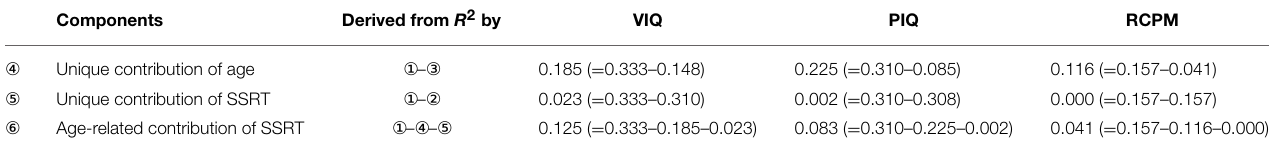
TABLE 5 | Components of variance in explaining VIQ, PIQ, and RCPM.